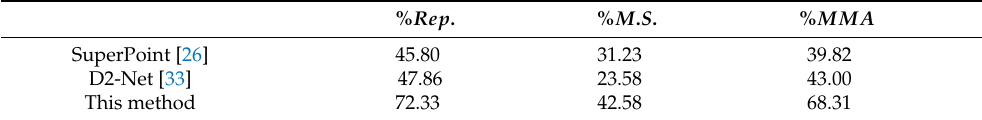
Table 2. Comparison of the local descriptor matching performance between this method and other methods on the HPatches dataset (HPatches dataset error threshold @4 px ).